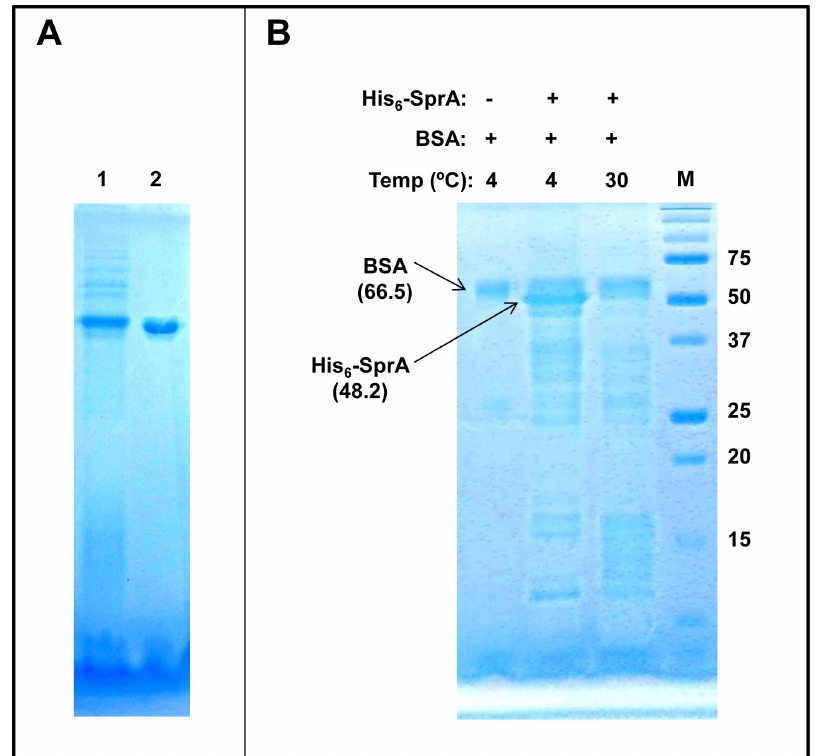
Figure 6. Proteolytic specificity of His 6 -SprA. Proteolytic assays were performed as described in the Materials and Methods. Proteins were incubated at 4 u C or 30 u C for 24 h, analyzed on a 15% SDS-PAGE gel, and then visualized by staining with Coomassie brilliant blue G250. Lanes 1 and 2 (A) show digested His 6 -SprA (identical to lane 6 in Figure 5) and purified MBP, respectively. (B) Digestion of bovine serum albumin (BSA) with His 6 - SprA. Molecular weights are shown in kDa, and M denotes the protein marker.